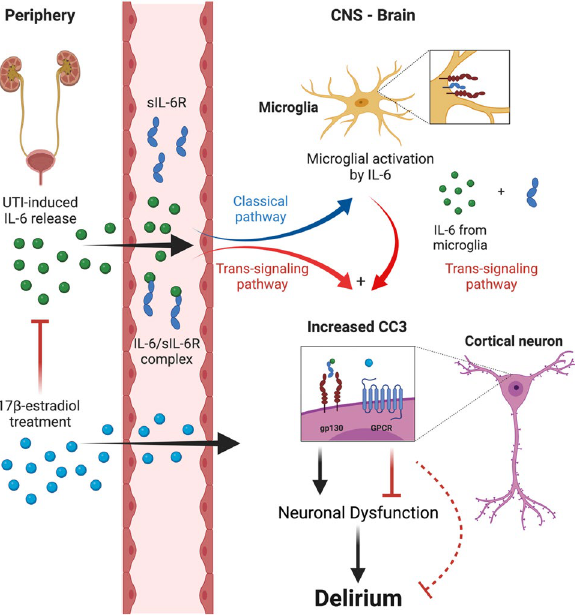
Figure 7. Hypothesized schematic of the IL-6 trans -signaling pathway and protective effects of 17β-estradiol. UTI-induced increases in IL-6 and soluble IL-6R (sIL-6R) complex in the periphery and directly induce neuronal dysfunction (i.e., increased frontal cortex and hippocampal CC3) via the gp130 transmembrane protein. 17β-estradiol reduces systemic and central inflammation and provides protective effects via reduction in neuronal CC3 mediated through neuronal G-protein estrogen receptor. Figure is adapted from Hogg et al. 55 . Created with